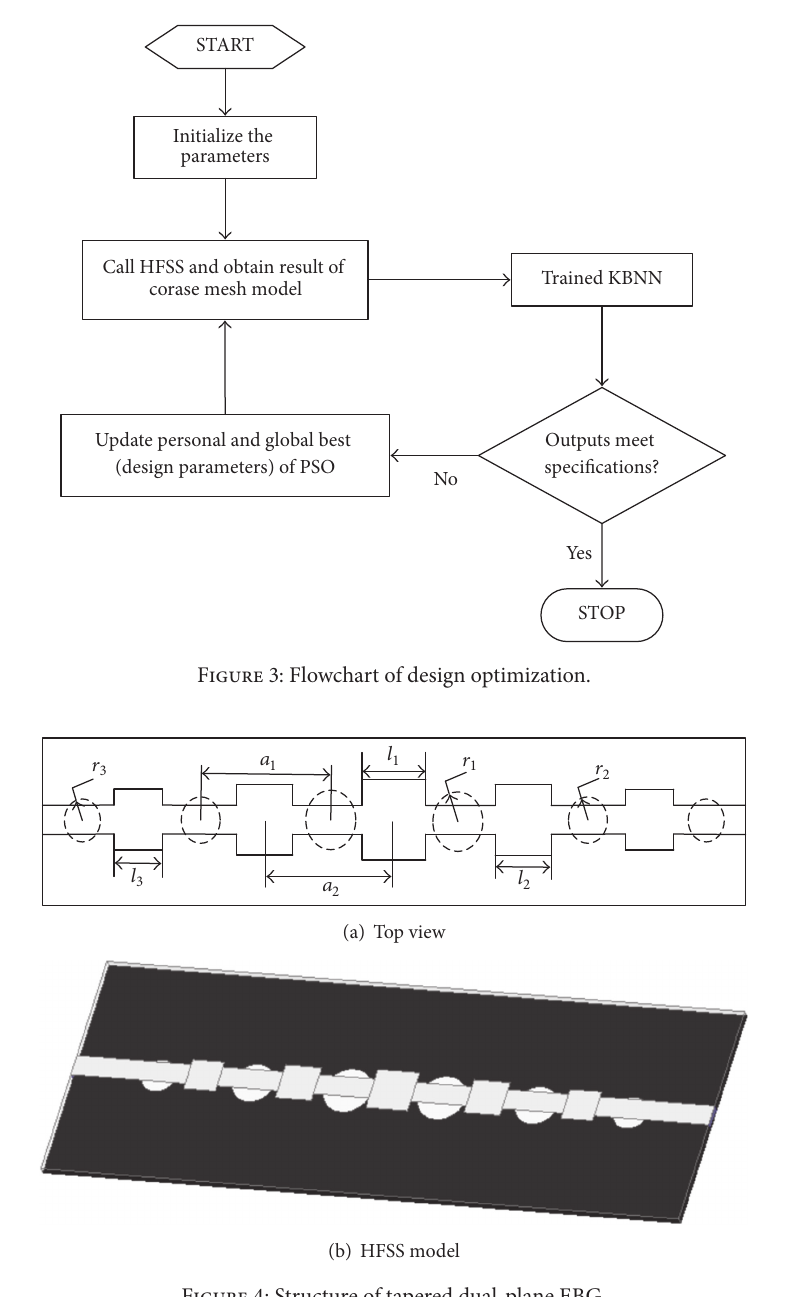
Figure 4: Structure of tapered dual-plane